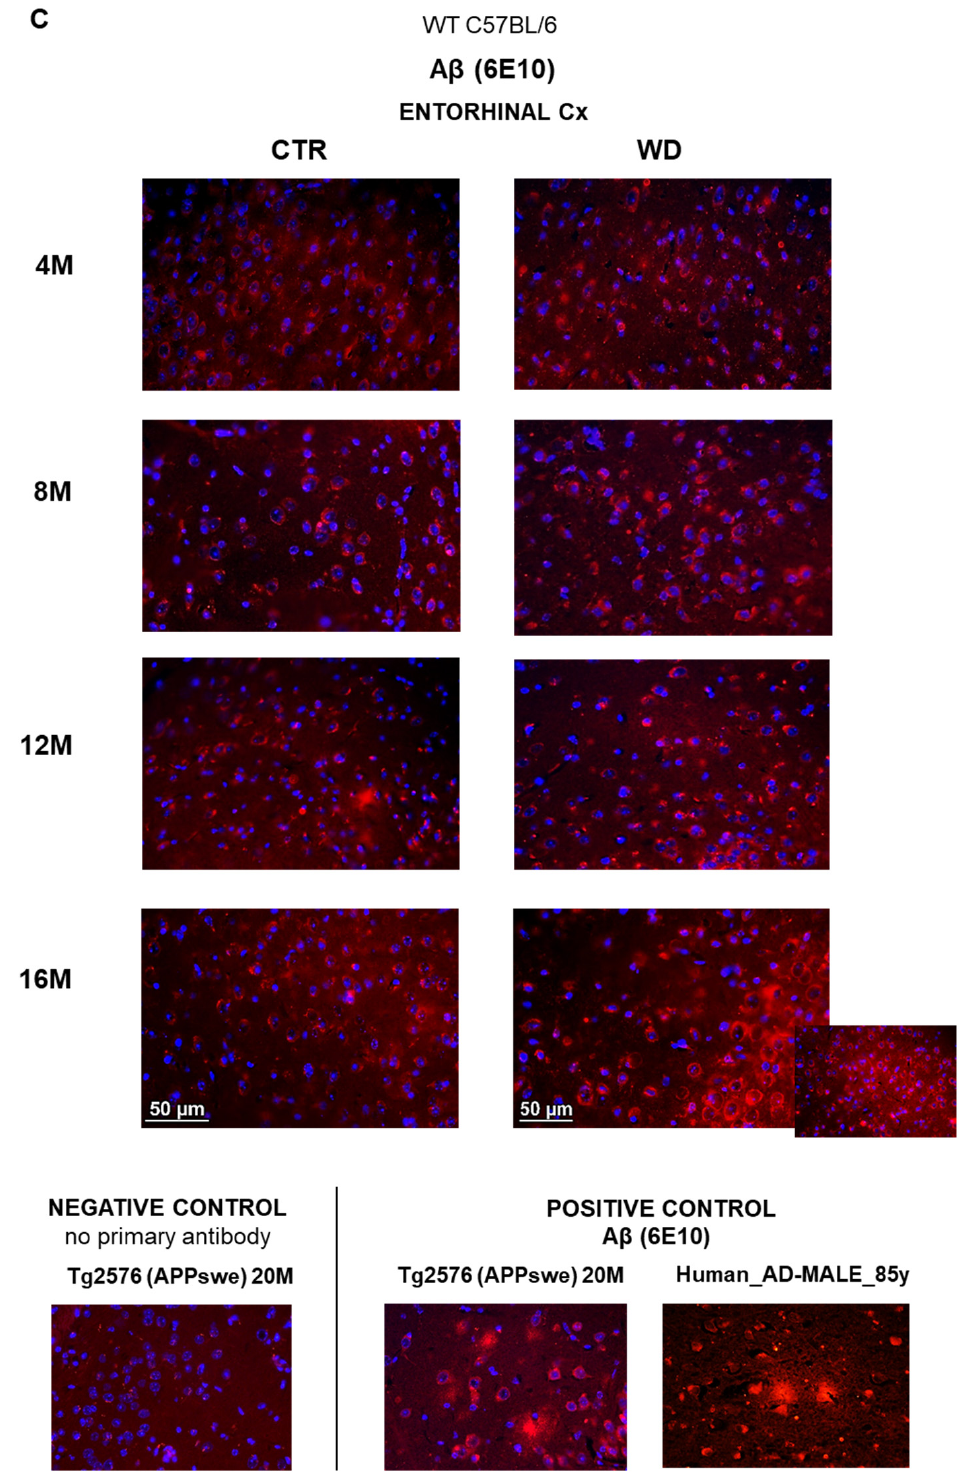
Figure 4. The levels of full-length APP in the entorhinal cortex and in the hippocampus of WT C57BL/6J mice. ( A ) Quantification and statistical analysis. ( B ) Representative source Western blots. Statistical analysis comprised the Shapiro–Wilk normality test, two-way ANOVA, and Tukey’s post hoc test; significant results: Entorhinal cortex APP: (4M WD vs. 16M WD ( p -Value = 0.0314); 8M WD vs. 16M WD ( p -Value = 0.0113); 12M WD vs. 16M WD ( p -Value < 0.0001); Hippocampus APP: (4M CTR vs. 4M WD ( p -Value = 0.0424)). The source figures from Western blot analysis are attached in Appendix A: Figure A3a,b; completed statistical data are in Supplementary Materials: Table S3. ( C )